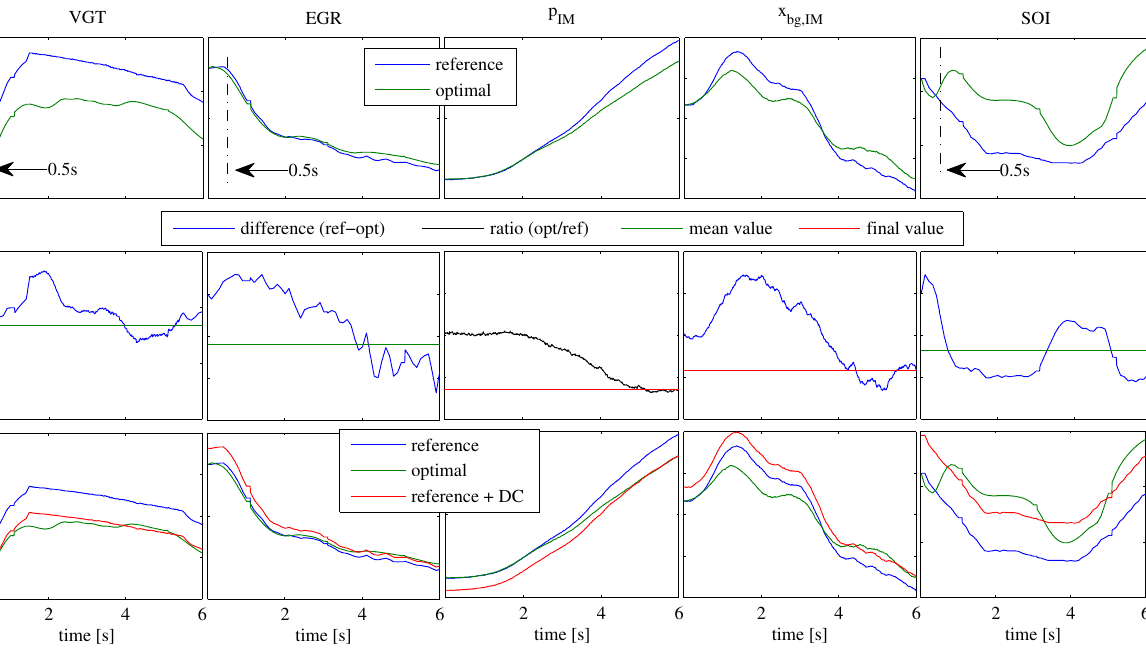
Figure 9. Example of calculation of the dynamic compensation (DC) factor, for the 6 s ramp. First row : comparison between reference and optimal trajectories. Second row : difference (blue line) and ratio (black line) between optimal and reference trajectories. Compensation factors are derived by using either the average (green line) or the final value (red line) of the respective compensation vectors. Third row : comparison between optimal solutions and dynamically compensated reference control